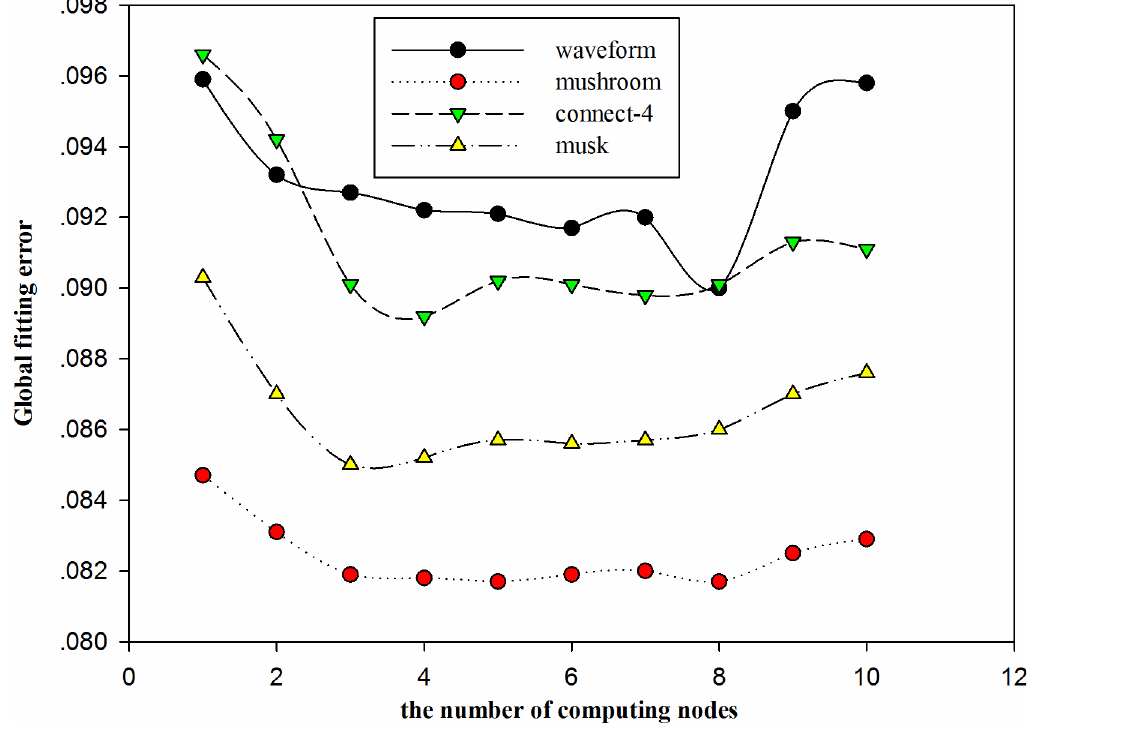
Fig 4. Comparison of the global fitting error for all of the tested datasets under different grid